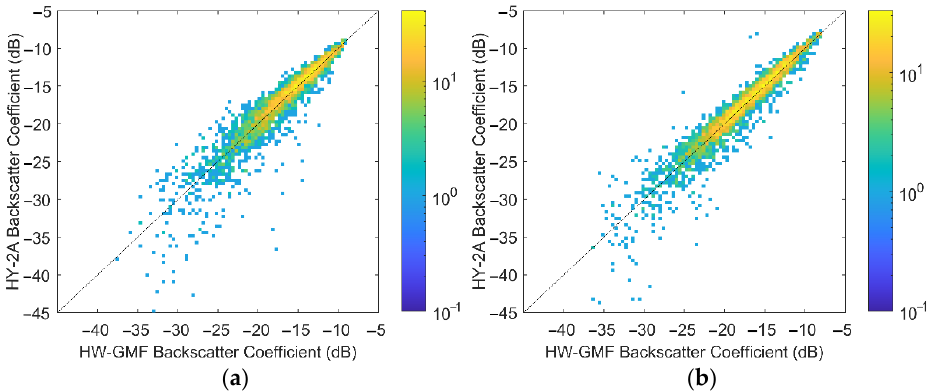
Figure 7. Scatter plots of HW ‐ GMF σ 0 and HY ‐ 2A σ 0 paired data. ( a ) HH polarization. ( b ) VV polarization. The dashed line in this figure is the diagonal line.